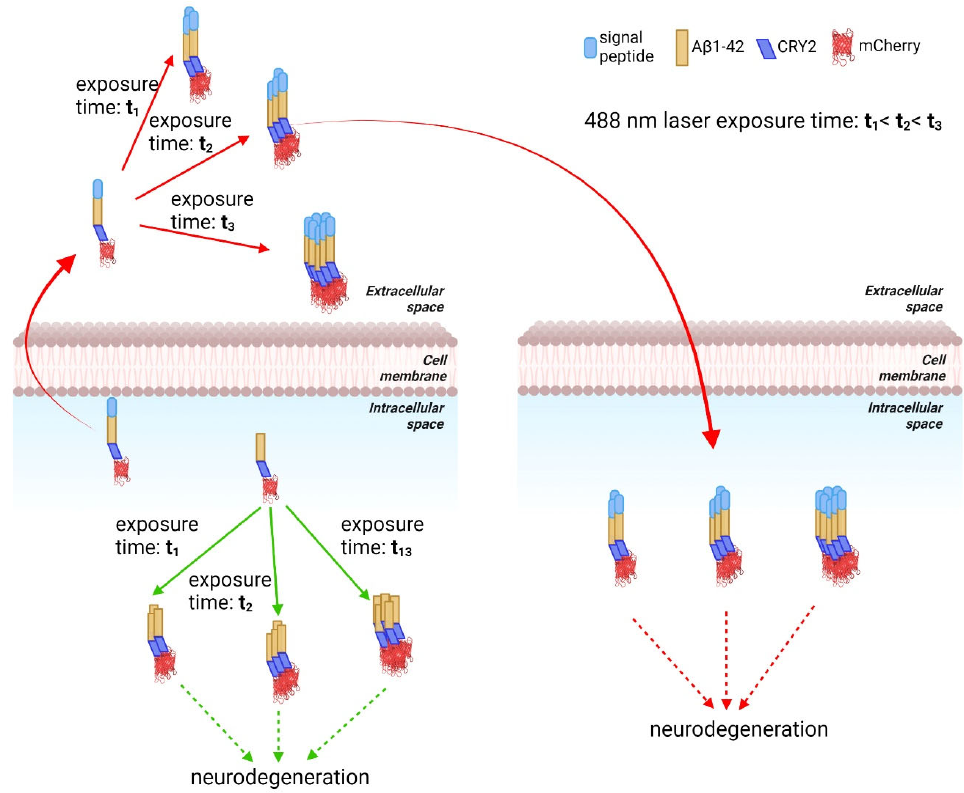
Figure 3. An optogenetic strategy to vary levels of amyloid in intracellular and extracellular space. Cryptochrome 2 (Cry2)-mCherry A β aggregates upon exposure to 488 nm laser light. By controlling the exposure time, the level of aggregation can be varied. A signal peptide for secretion to extracellular space can be added to CRY2 ‐ mCherry A β . Neighboring cells can import the then secreted A β .